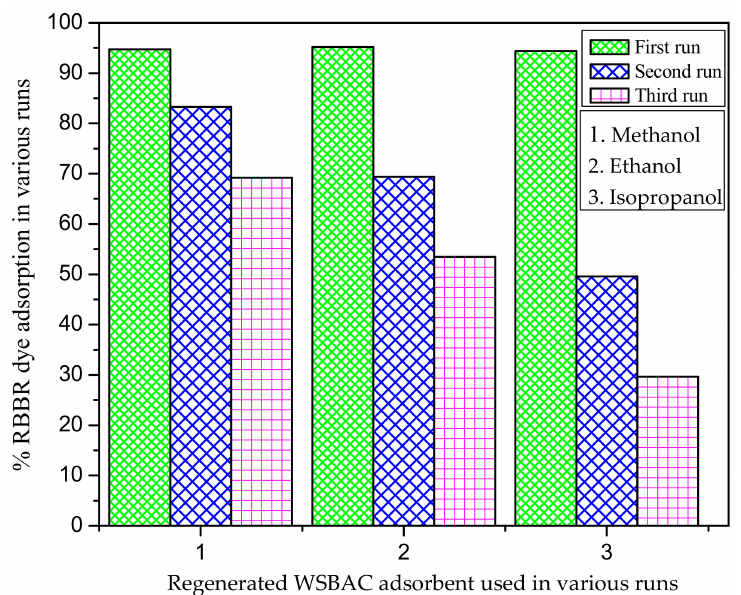
Figure 17. Reusability of WSBAC adsorbent for the adsorption of RBBR dye in various runs. (Initial pH: 2; initial dye concentration: 175 mg L − 1 ; volume of dye solution: 100 mL; agitation speed: 150 rpm; temperature: 301 K; contact time: 24